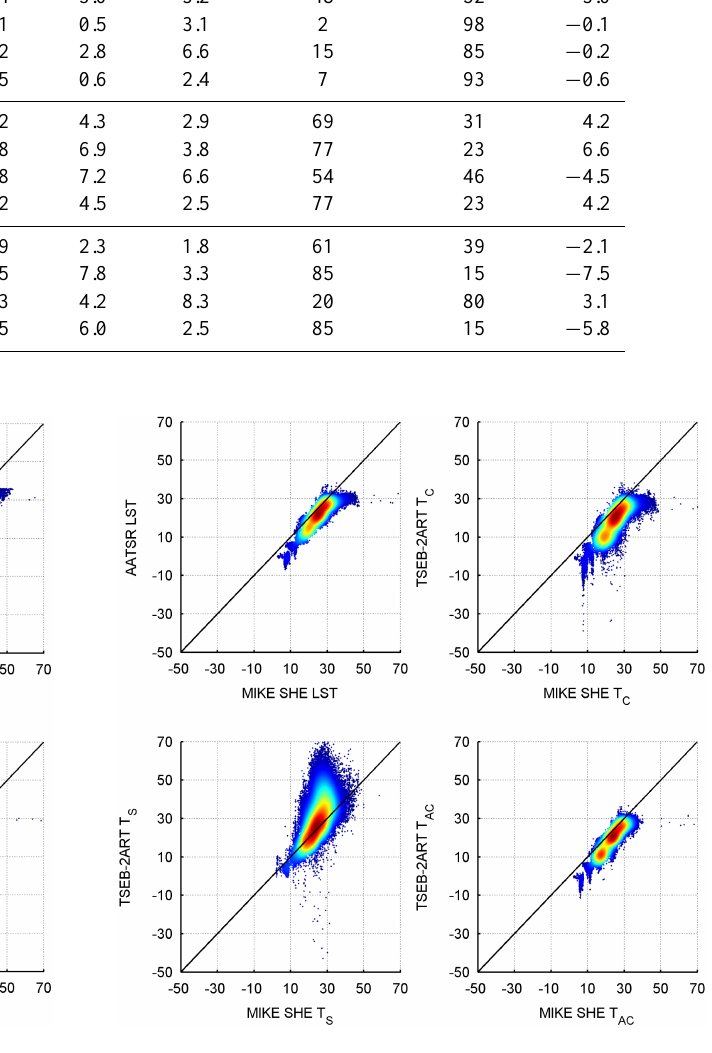
Figure 13. Density scatter plot of over 95000 points comparing land surface temperature (top left), canopy temperature (top right), soil temperature (bottom left) and in-canopy air temperature (bot- tom right). Land surface temperature on the x axis was modelled by MIKE SHE and on the y axis came from nadir observations by AATSR sensor on the Envisat satellite. The other temperatures were modelled by both MIKE SHE and TSEB-2ART. Red colour indi- cates higher density of points, blue colour lower